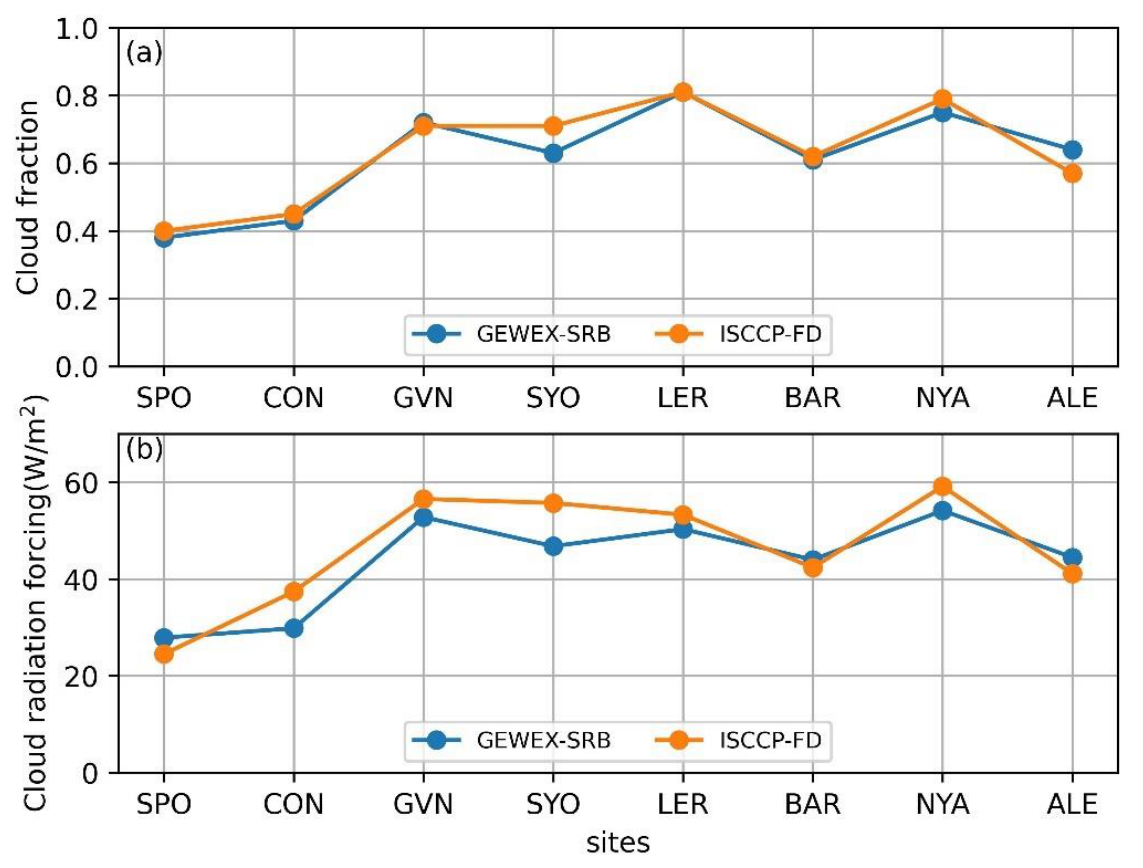
Figure 6. The year mean values of cloud fraction and cloud longwave radiation forcing from GEWEX-SRB and ISCCP-FD products at 8 sites. SPO to SYO sites are in Antarctica, and LER to ALE sites are in Arctic. The latitudes of these sites are ascending from −89.983° (SPO) to 82.490° (ALE).